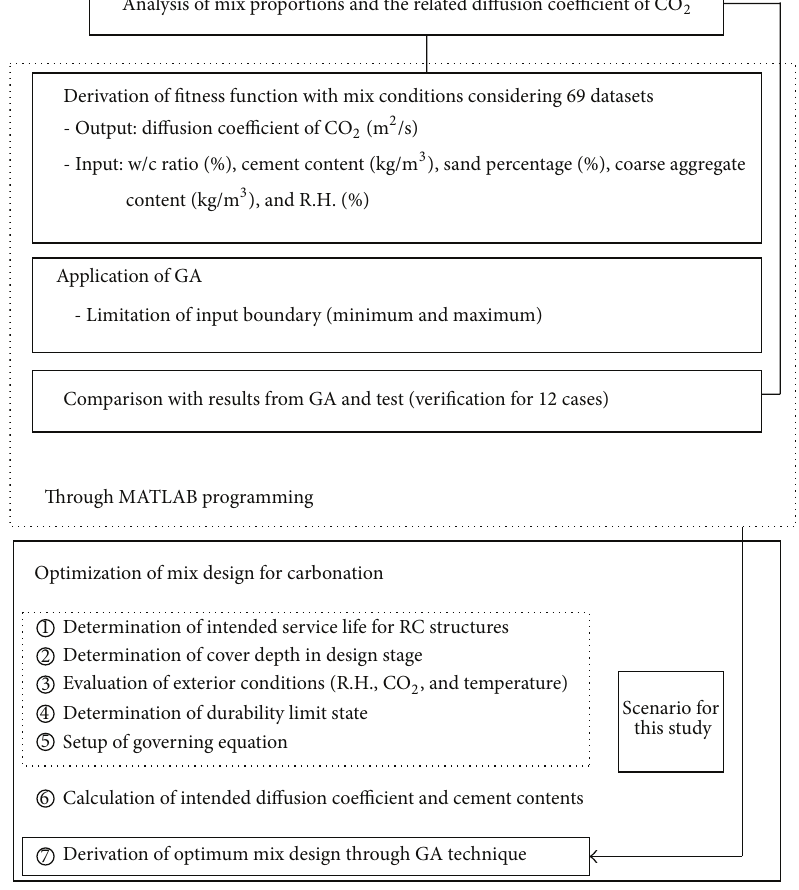
Figure 2: Flowchart for this concrete mix optimization.